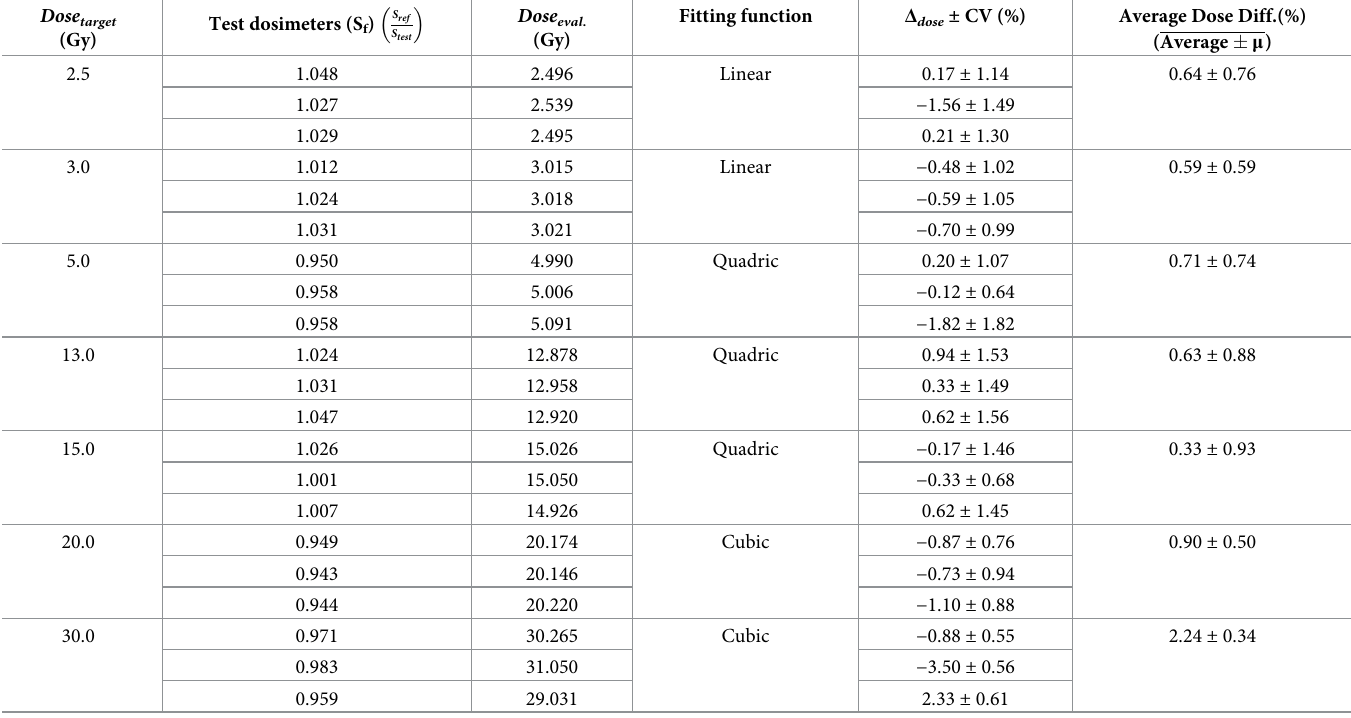
Table 2. Difference between the target and evaluated doses in various doses (from 2.5 Gy to 30 Gy) determined using the in-house software program (“Average” and “SD” indicate the average and standard deviation of the test dosimeters (N = 3) in each dose; CV means variation of the reproducibility for each test